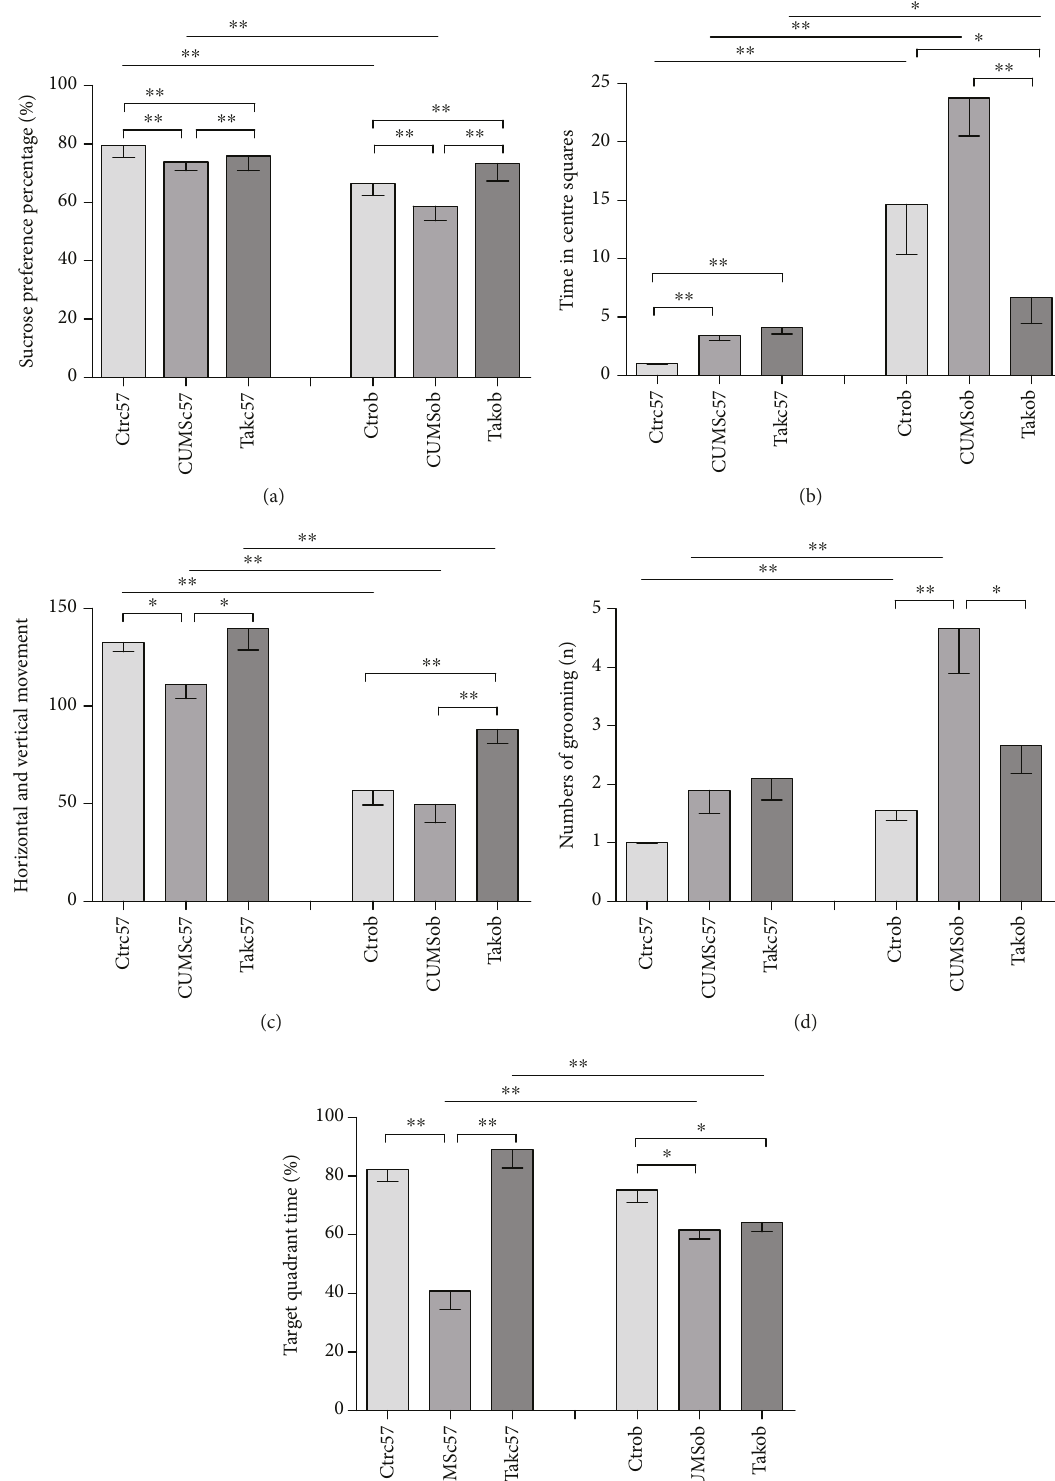
Figure 2: The comparison of behavior changes in di ff erent groups: (a) sucrose preference percentage in the SPT; (b) time in centre squares in the OFT; (c) number of horizontal and vertical movements in the OFT; (d) number of grooming in the OFT; (e) percentage of time spent in the target quadrant in the MWM test. Results are shown as mean ± SEM ( n = 10 in each group). ∗ p < 0 05 and ∗∗ p < 0 01